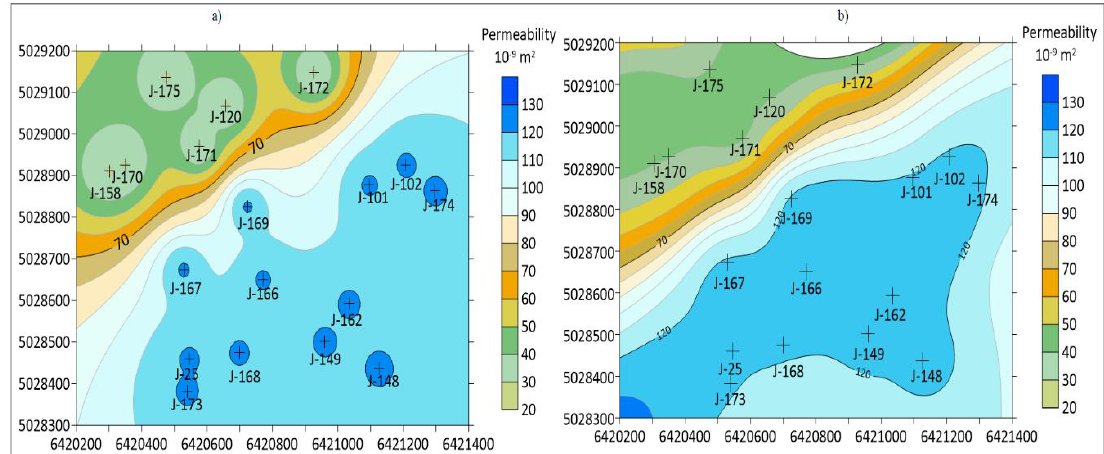
Figure 8. Porosity of reservoir “K”: ( a ) IDW; ( b ) MSM.